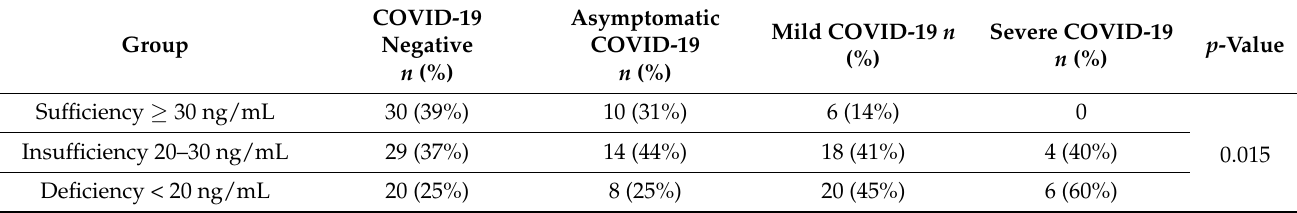
Table 2. Distribution of the patients according to 25-OH vitamin D levels.